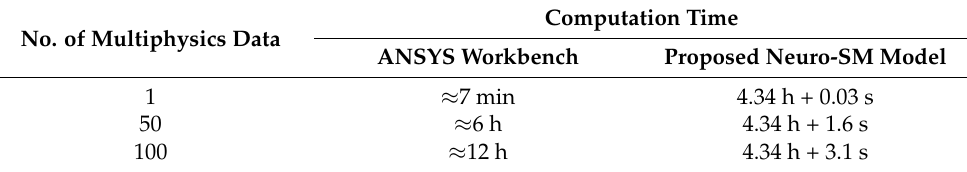
Table 3. Comparison of computation time between the multiphysics software simulation and the proposed Neuro-SM multiphysics model (25 data) for the iris coupled microwave cavity filter. Computation Time No. of Multiphysics Data ANSYS Workbench